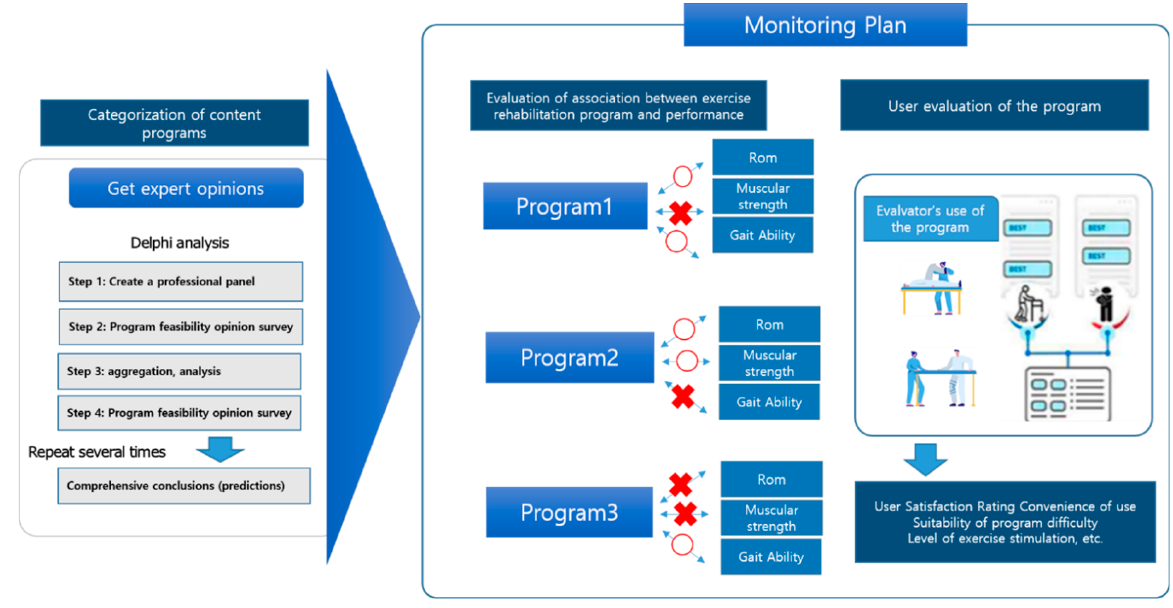
Figure 4. Monitoring plan.